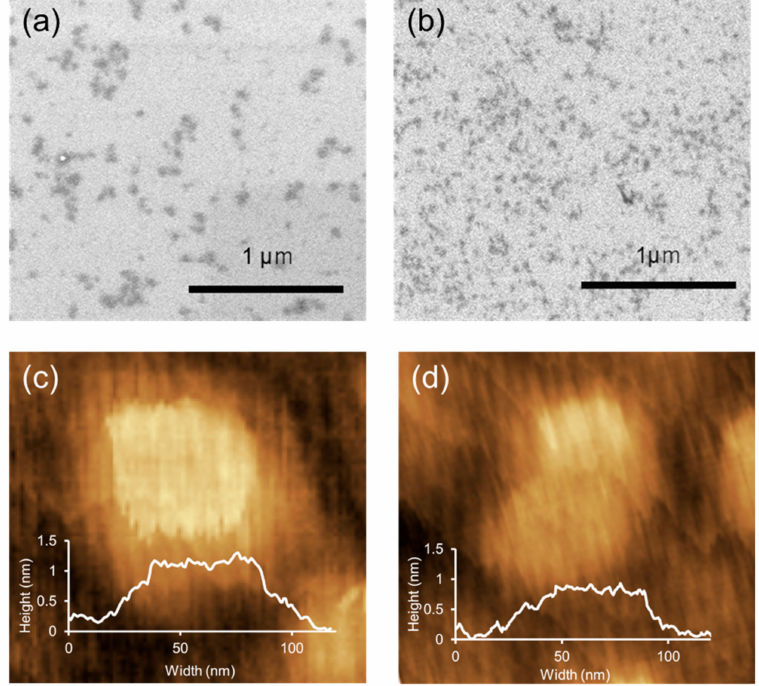
Figure 1. SEM images of graphene dispersed by ( a ) octylbenzene and ( b ) 1,4-dioctylbenzene, and AFM images of graphene dispersed by ( c ) octylbenzene and ( d )